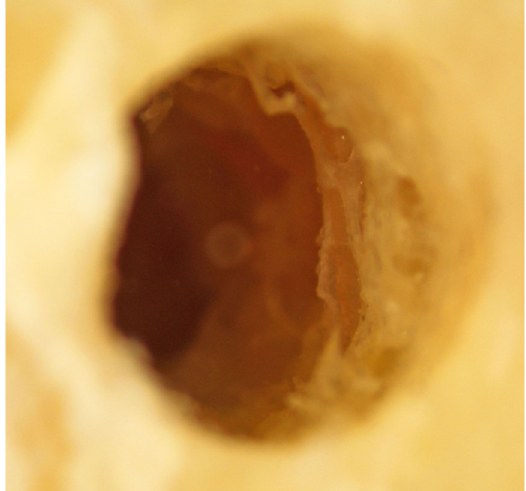
Figure 11. The Densah ® burs’ tibial section under the Nikon ® stereomicroscope, showing similar findings with the MIS ® drills’ tibial section. Irregularities over the osteotomy walls can be seen, suggesting non-condensed cortical bone.